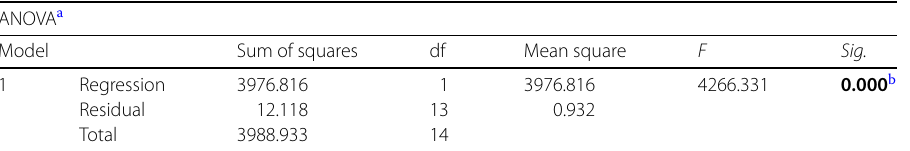
Table 9 ANOVA table of the physical and mechanical properties of breaking load-compressive strength ANOVA